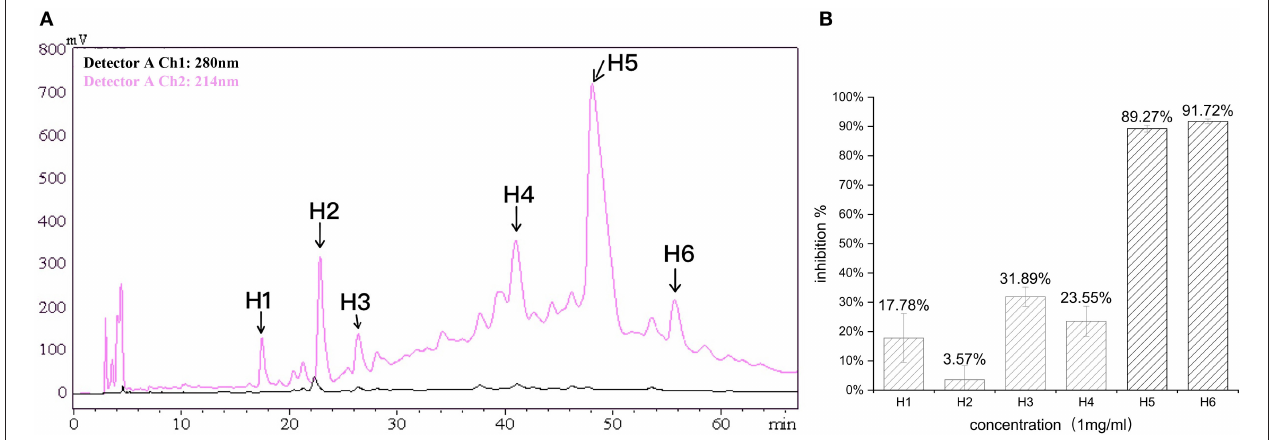
FIGURE 4 | (A) Reverse-phase HPLC chromatogram of third-step purification of the S2 fraction; (B) inhibitory activity of six fractions (H1–H6).